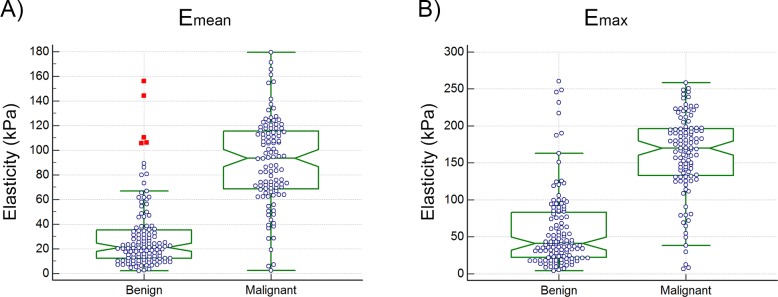
(A) Elasticity distribution based on mean elasticity values and (B) Elasticity distribution based on maximum elasticity values for benign and malignant masses. The red markers show the data points outside the upper quartile plus 3 times the interquartile range. Median separation was 71.65kPa for mean elasticity and 133.27kPa for maximum elasticity.